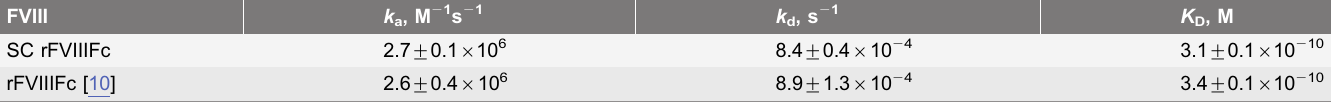
Table 3. Affinities of SC rFVIIIFc and rFVIIIFc for VWF by SPR (n 5 6, Mean ¡ SD) [10].